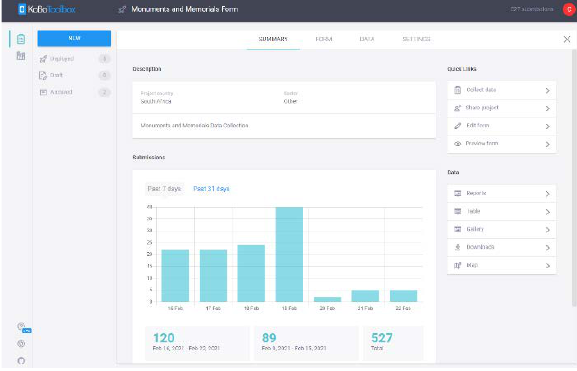
Figure 3: KoBoToolbox management interface